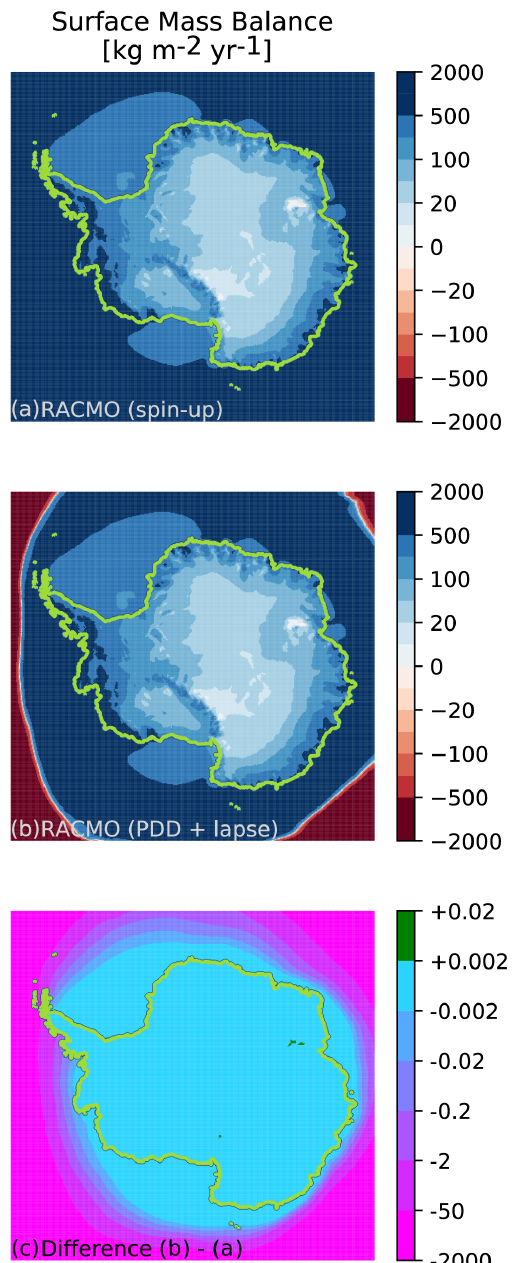
Figure E16. Surface mass balance (SMB) used during the spin-up ( a ), the surface mass balance computed via the positive-degree-day (PDD) approach ( b ) under preindustrial conditions, and the difference between these ( c ). For the panel under preindustrial conditions ( b ), the lapse correction is also active, which does not impact the results because the height difference is initially neglectable. The unit of the surface mass balance and its difference are kilograms per square meter per year (kgm − 2 yr − 1 ); note that 1kgm − 2 yr − 1 equals 1mm(WE)yr − 1 (WE represents water equivalent). In each subplot, the light-green contour lines represent the outer edge of the ice sheet or ice shelves, respectively. Approximately south of the annual sea ice edge, the difference between both SMB fields is essentially zero except for two restricted areas. One near the Amery Ice Shelf and the other at the Transantarctic mountain range east of the Ross Ice Shelf. These two regions are characterized by a negative SMB in the spin-up data distribution ( a ), which is absent in the PDD-deduced SMB ( b ). Moreover, only the northern tip of the Antarctic Peninsula experiences a different forcing. Further north, the difference is significant; however, this difference does not impact the Antarctic ice